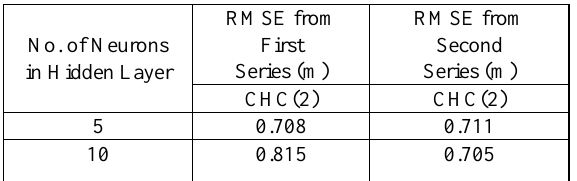
Table 6. Results of Interpolation using